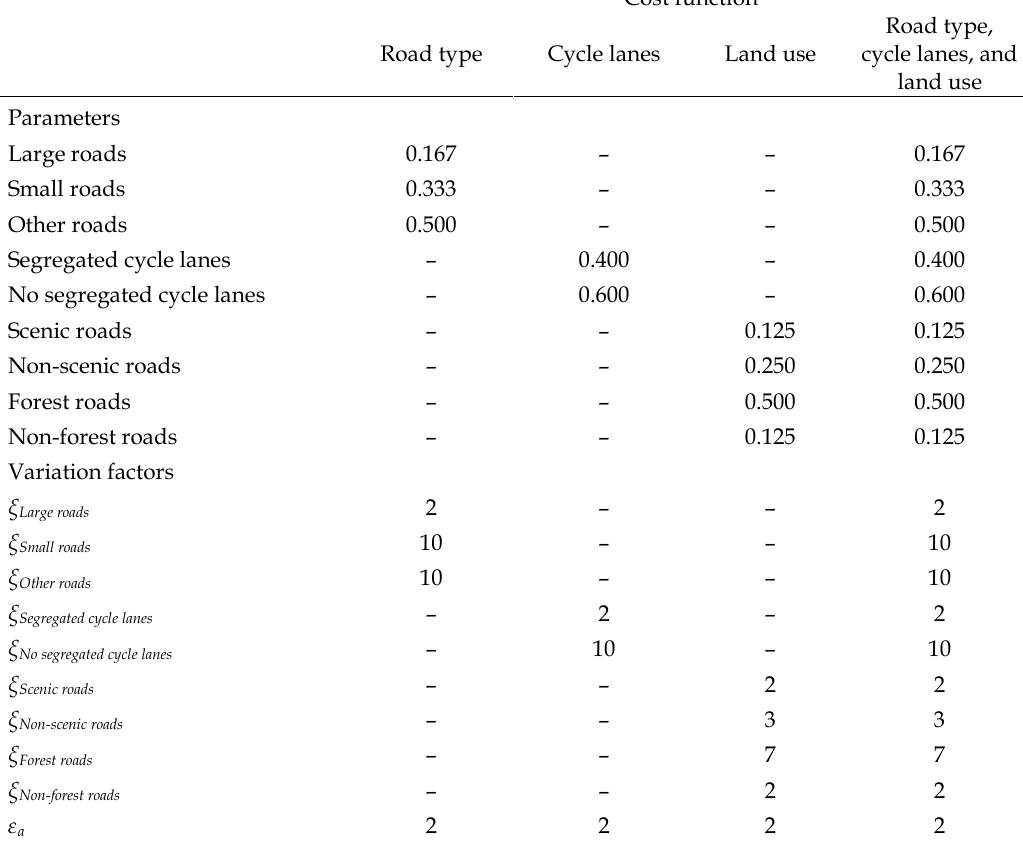
Table 2. Overview of the calibrated parameters and variation